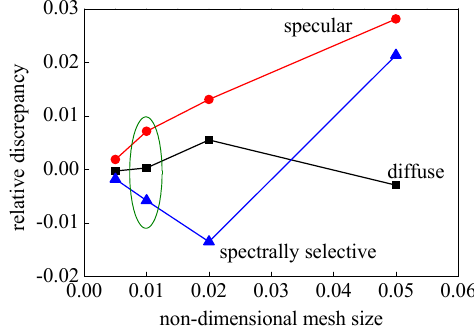
Figure 3. Results of mesh-independence and code validation studies. Mesh size is non-dimensionalized by the emitter diameter d . The relative discrepancy is that compared to analytical predictions.